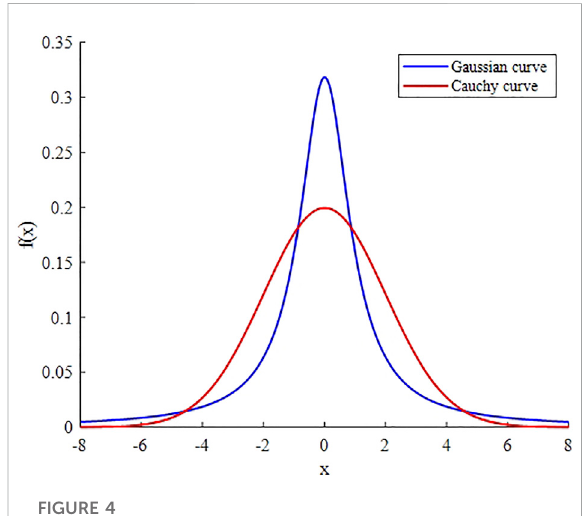
FIGURE 4 Gaussian curve and Cauchy curve distribution